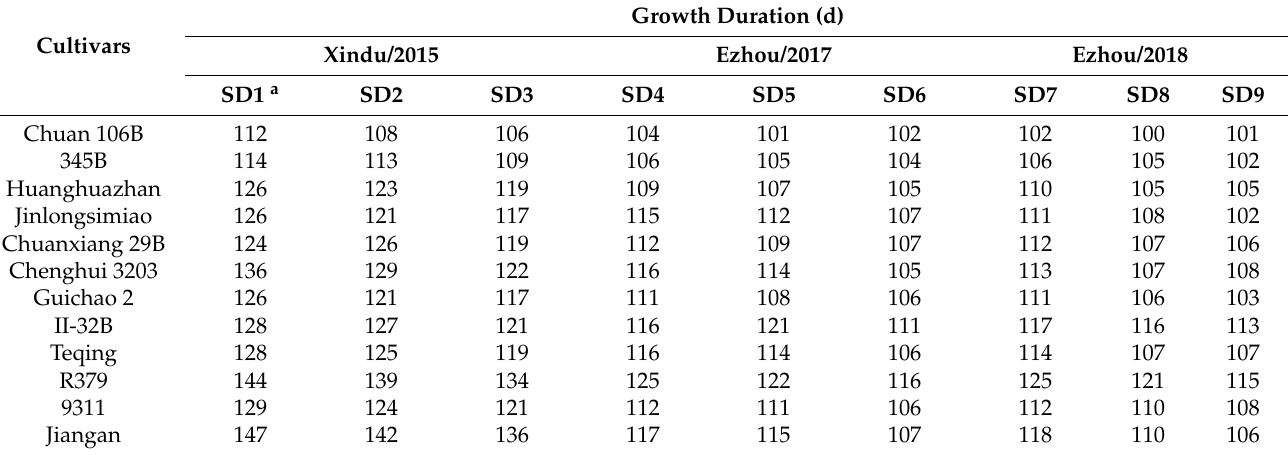
Table 1. The determined growth durations (days) of twelve indica rice cultivars on all the sowing dates across two locations and three